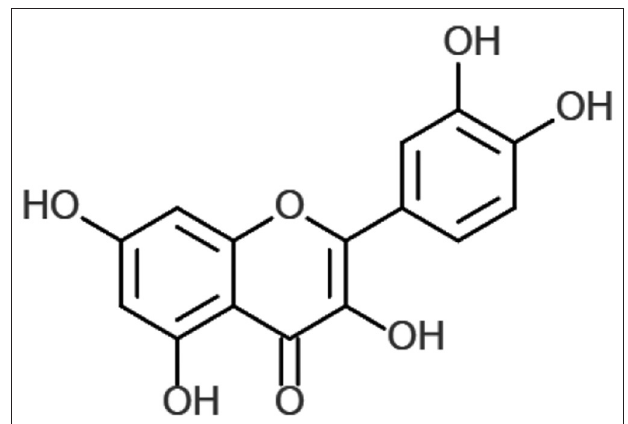
FIGURE 1 | Chemical structure of quercetin. Created with ChemDoodle Web with permission